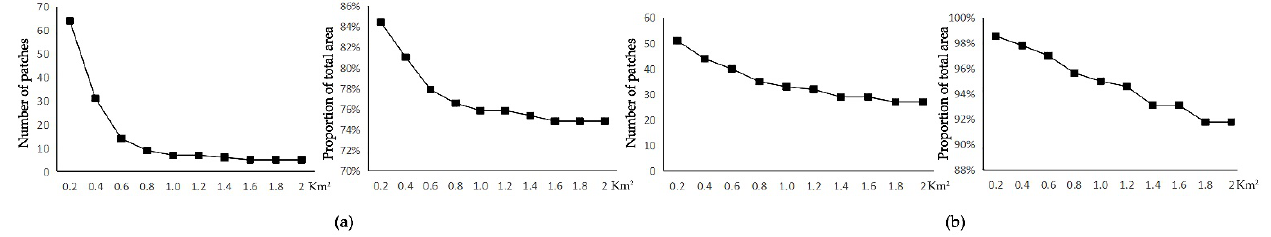
Figure 7. Effect of setting minimum area thresholds on plaque: ( a ) setting minimum area thresholds of ecological patches; and ( b ) setting minimum area thresholds on recreational patches.